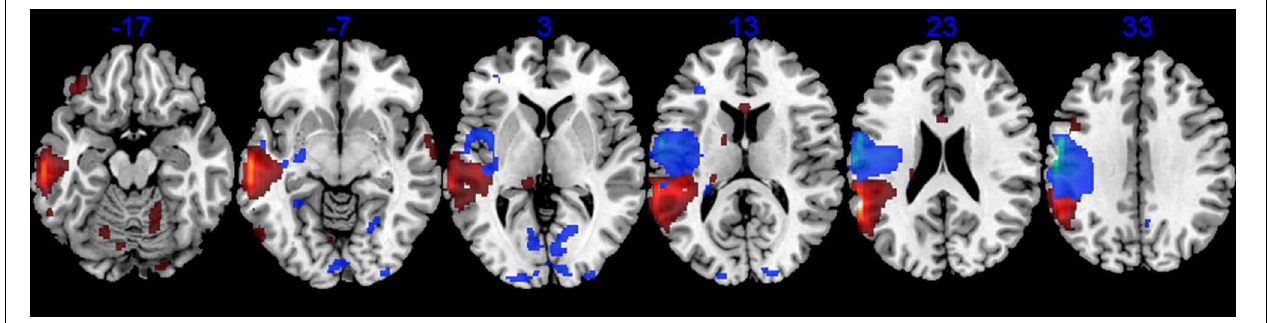
lesion in RTP was more superficial than the one in JGG (see Figure 2 ), decreased metabolic activity extended deeply to affect white matter in both cases. The left hemisphere is represented on the left side of the